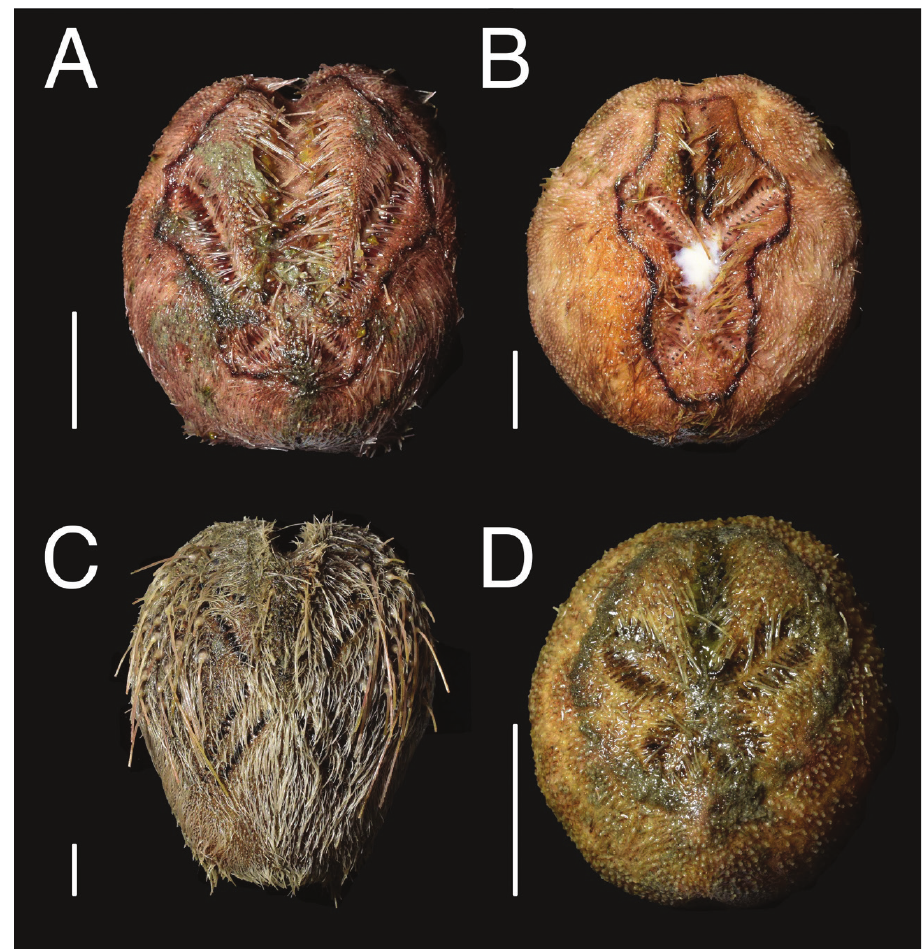
Figure 3. Four of the five irregular sea urchin species that were contained in the same haul with Benthoscolex seisuiae sp. n., aboral view. A Brisaster latifrons (A. Agassiz, 1898), NSMT E-10723 B Bris- sopsis luzonica (Gray, 1851), NSMT E-10721 C Lovenia gregalis Alcock, 1893, NSMT E-10719 D Schi- zaster sp., NSMT E-10725. Scale bars 1